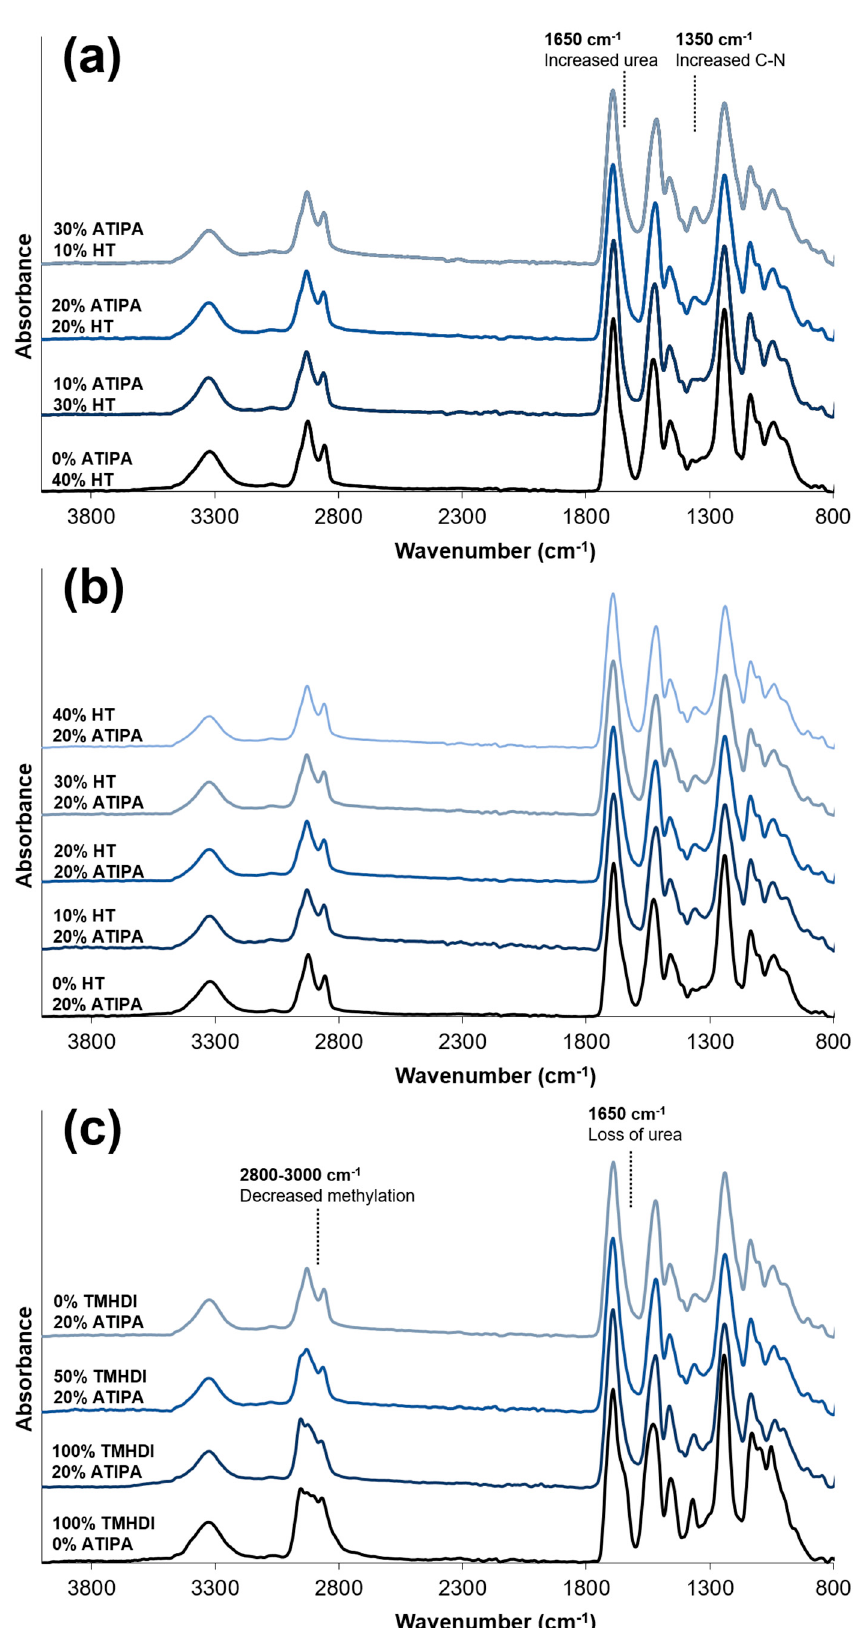
Figure 3. Attenuated Total Reflectance Fourier Transform Infrared (ATR FTIR) spectra for foams with varying ( a ) 5-amino-2,4,6-triiodoisophthalic acid (ATIPA) content; ( b ) 1,2,6-hexanetriol (HT) content; and ( c ) isocyanate content.